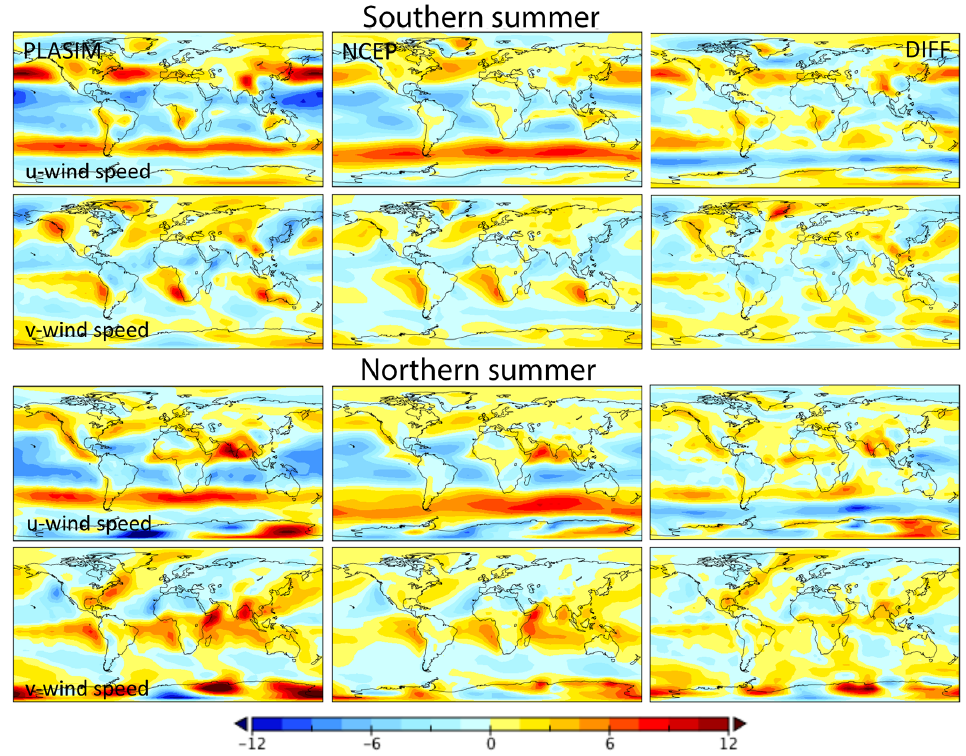
Figure 3. Seasonal surface zonal and meridional wind speeds (ms − 1 ) . Left: PLASIM–GENIE 50-year average. Centre: long-term average (1981–2010) NCEP/NCAR reanalysis fields (Kalnay et al., 1996). Right: difference